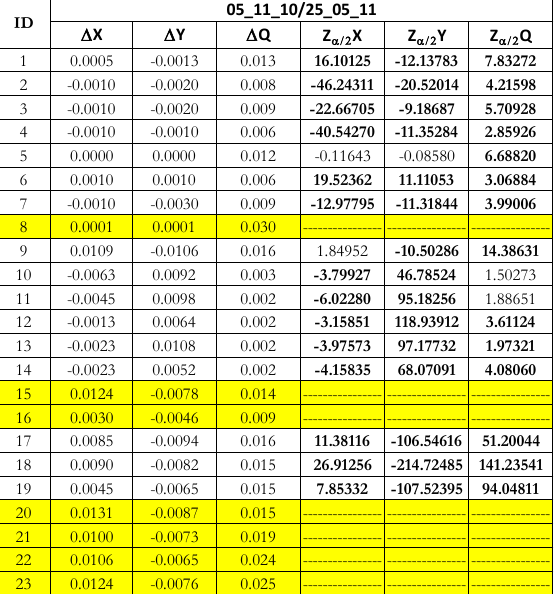
Table 7. Differences of adjusted coordinates and statistical analysis results between the first and the last